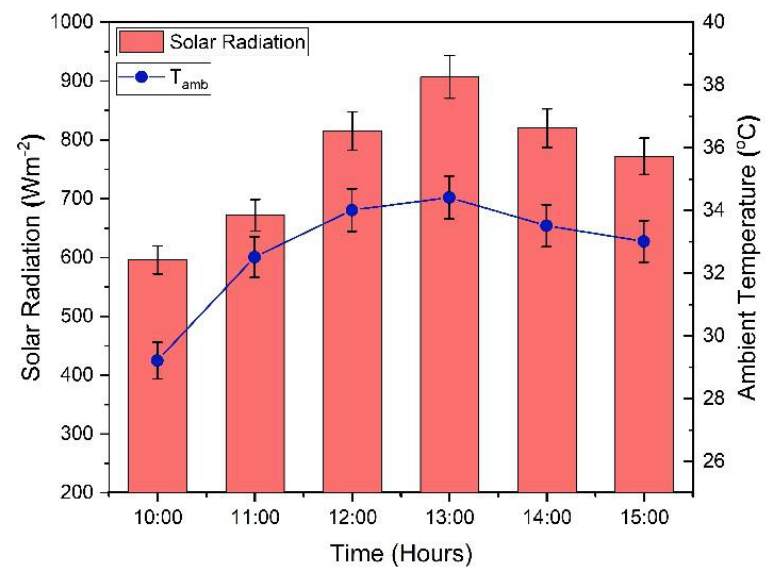
Figure 8. Average solar radiations and ambient temperature.